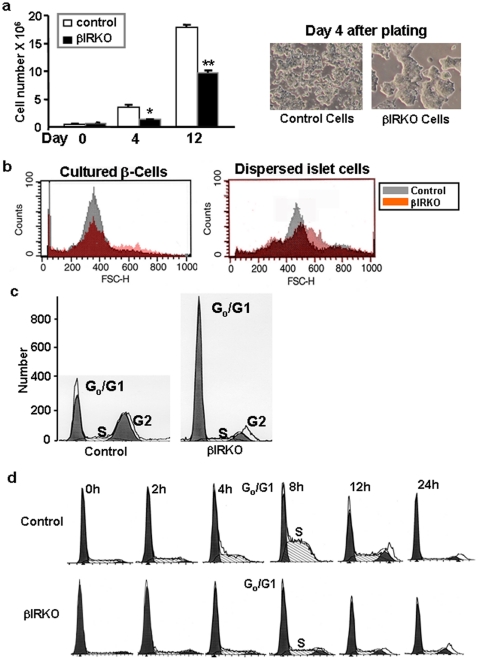
Insulin receptor-deficient β-cells exhibit slow growth and block in G1 to S-phase transition.(a) Defects in growth of βIRKO cells is evident from total number of cells 4 and 12 days after the same number of cells are plated at day 0; the panel on the right shows poor spread and clumping of βIRKO cells (b) β-cell size in control and βIRKO cell lines and islets determined by FACS analyses with forward scatter; (c) significantly lower G1 and G2 in βIRKO cells, and (d) block in G1 to S-phase transition in βIRKO cells after synchronization with hydroxyurea for 18h. Analyses were performed by FACS. In each case, representative data from 3 clones each derived from 3 RIP-Cre controls and 3 βIRKO mice are shown.